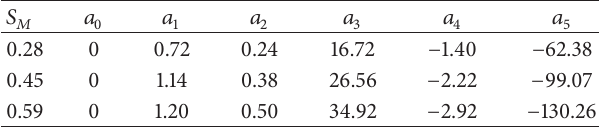
Table 2: Coefficients of the expressions for inflow velocity 𝑢 𝜃